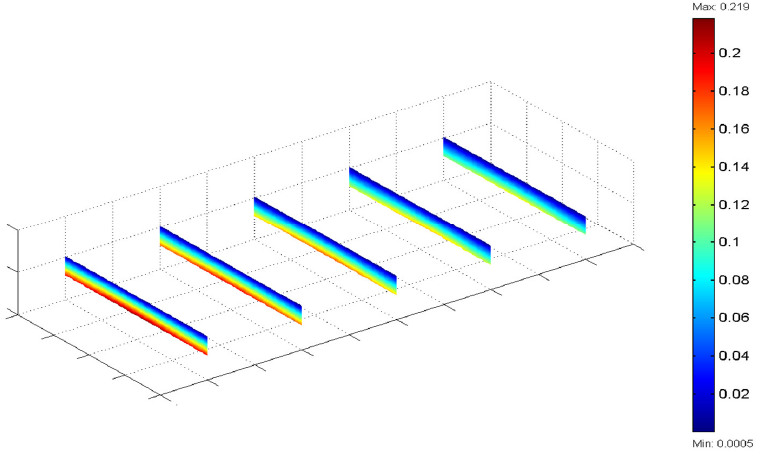
Figure 18. Variation of membrane overpotential throughout the membrane at peak power. Figure 19 demonstrates the variation of the CCL diffusion overpotentials (in Volts). The diffusion overpotential variation patterns are identical, with a higher value in the channel region location. Additionally, the local current density correlates with the profile of overpotential diffusion. From Figure 19, it was observed that the overpotential in the channel region was varied from the minimum value of 0.008 Volts at the exit of the chan- nel to the maximum achieved value of 0.0244 Volts at the entrance to the channel. Figure 19. Variation of diffusion overpotential at the CCL at peak power.